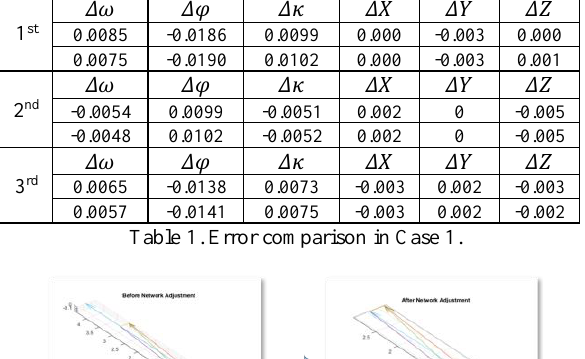
Figure 12. Images are taken in front of the department building